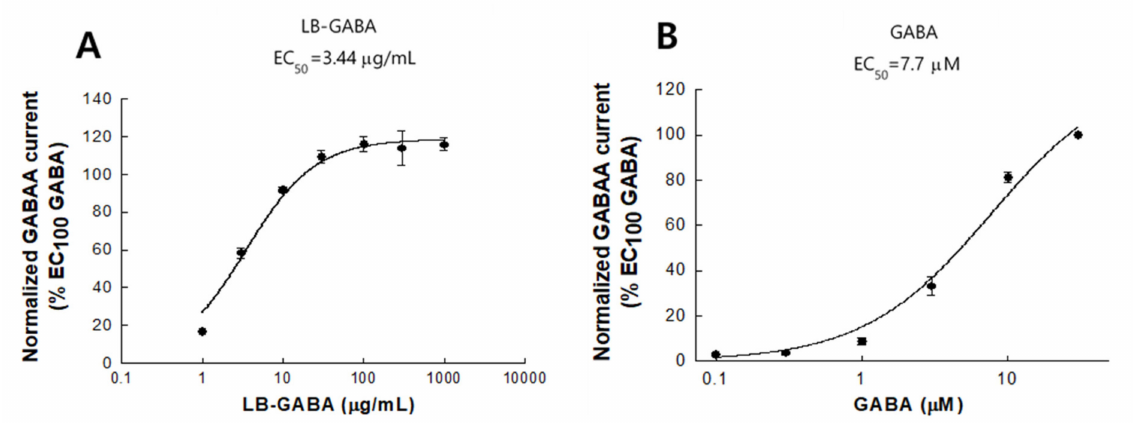
Figure 10. Agonist activity of Lactobacillus -fermented γ -aminobutyric acid (LB-GABA) on human GABA A receptor. Agonist activity of LB-GABA on human GABA A (hGABA A α 1 β 2 γ 2) receptor was tested using IonFlux HT electrophysiological platform. Current response to ( A ) LB-GABA or ( B ) synthetic GABA standard was dose-dependent in HEK293 cell expressing hGABA A α 1 β 2 γ 2. Experiments were independently performed three times. Maximal effective concentration (EC 100 ) of GABA was equal to current level of 30 µ M synthetic GABA. EC50, half-maximal effective